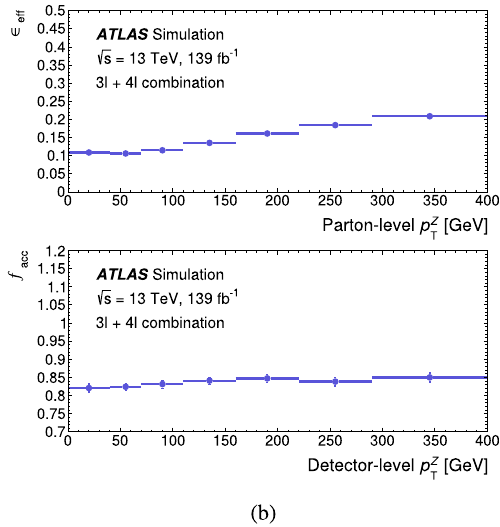
ton regions. The error bars represent the MC statistical uncertainties per bin based on the nominal signal